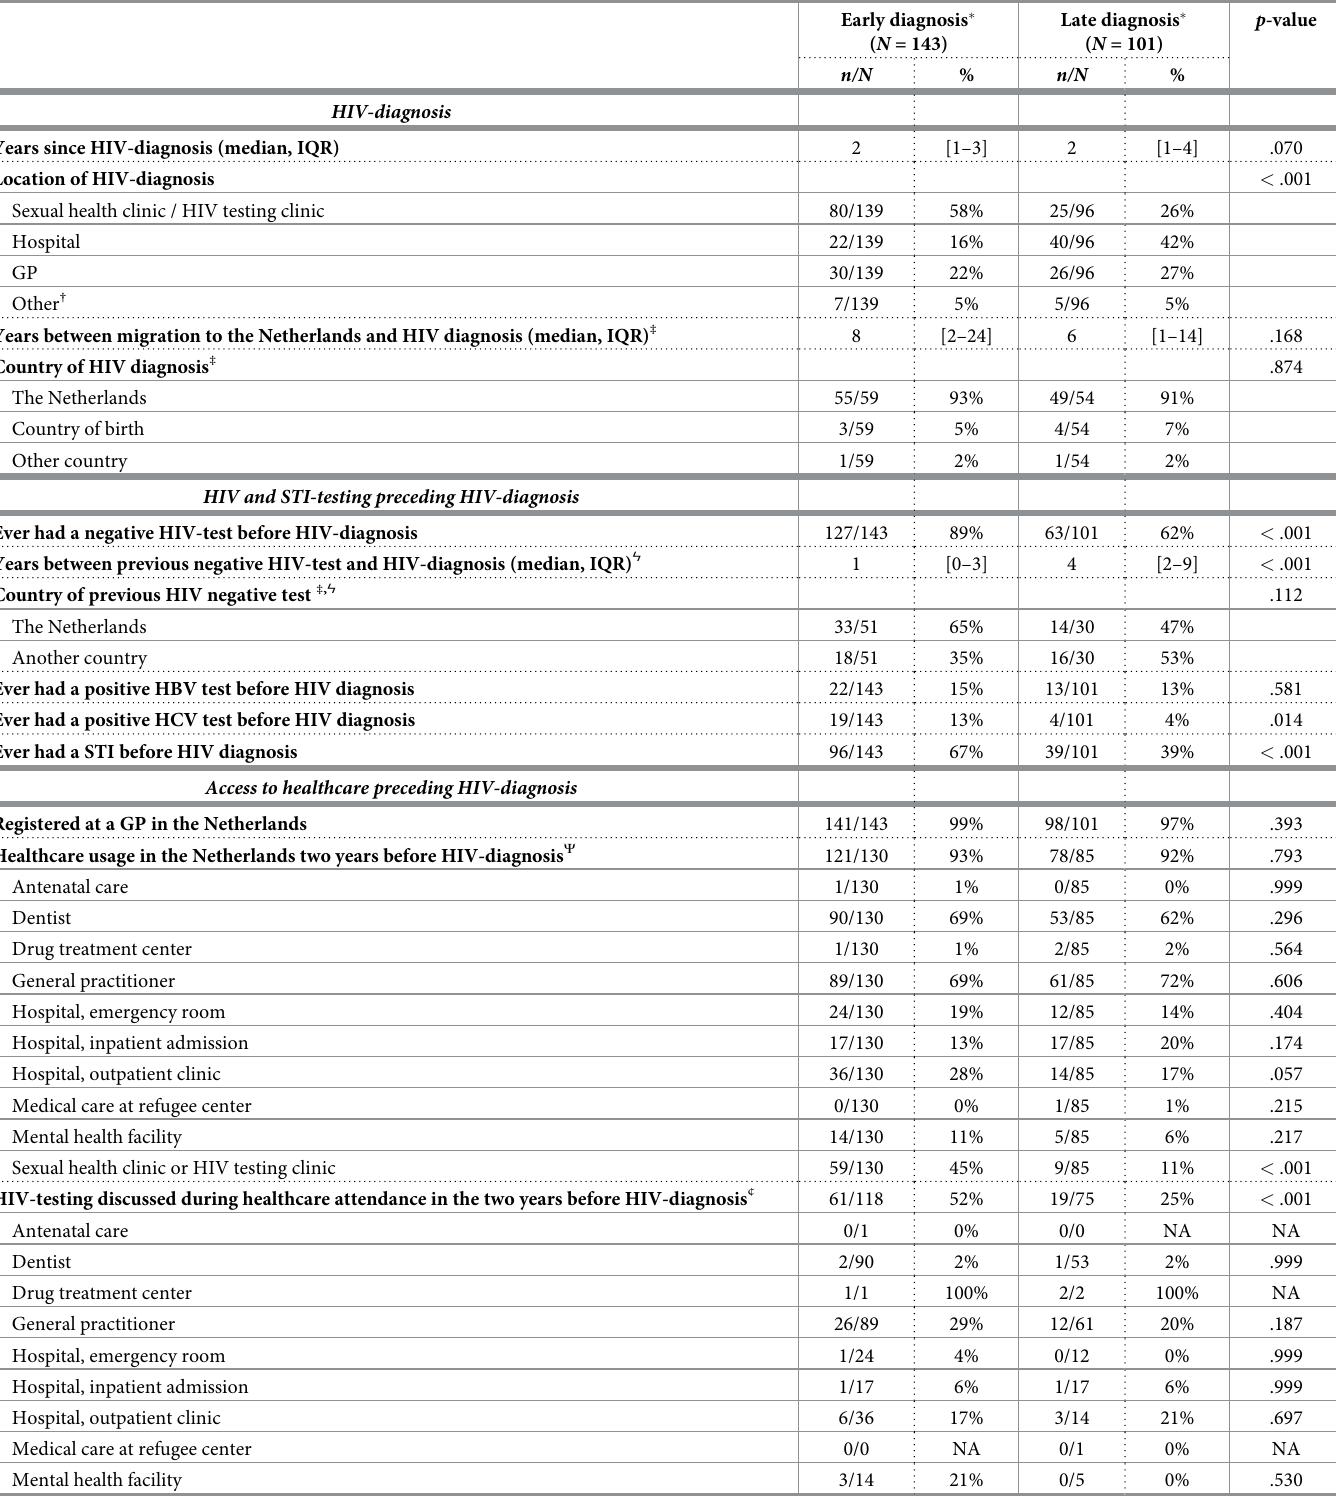
Table 2. HIV-diagnosis characteristics, HIV/STI-testing and access to healthcare preceding HIV-diagnosis among aMASE-study participants in the Netherlands, 2013–2015, stratified by early versus late HIV